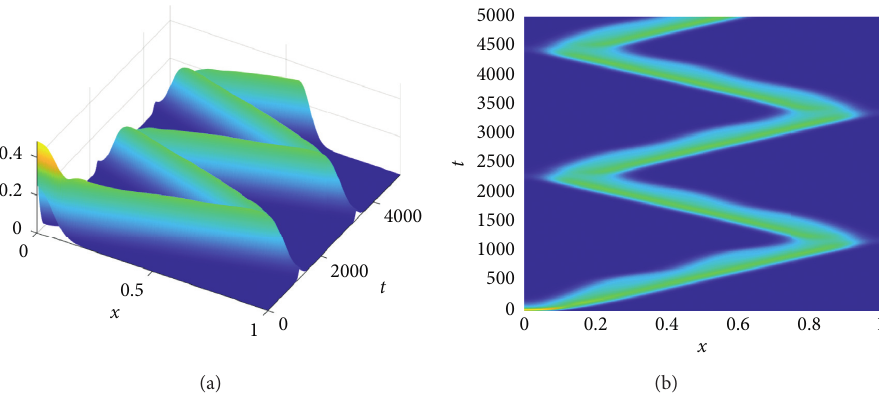
Figure 6: Propagation of the numerical solution of u for the 1D Gray–Scott model by the variable- θ method: (a) the pulse traveling and 2 reflecting and (b) its aerial view over 0 ≤ t ≤ T � 5000, when Δ t � 0 . 01 and Δ x � 0 .